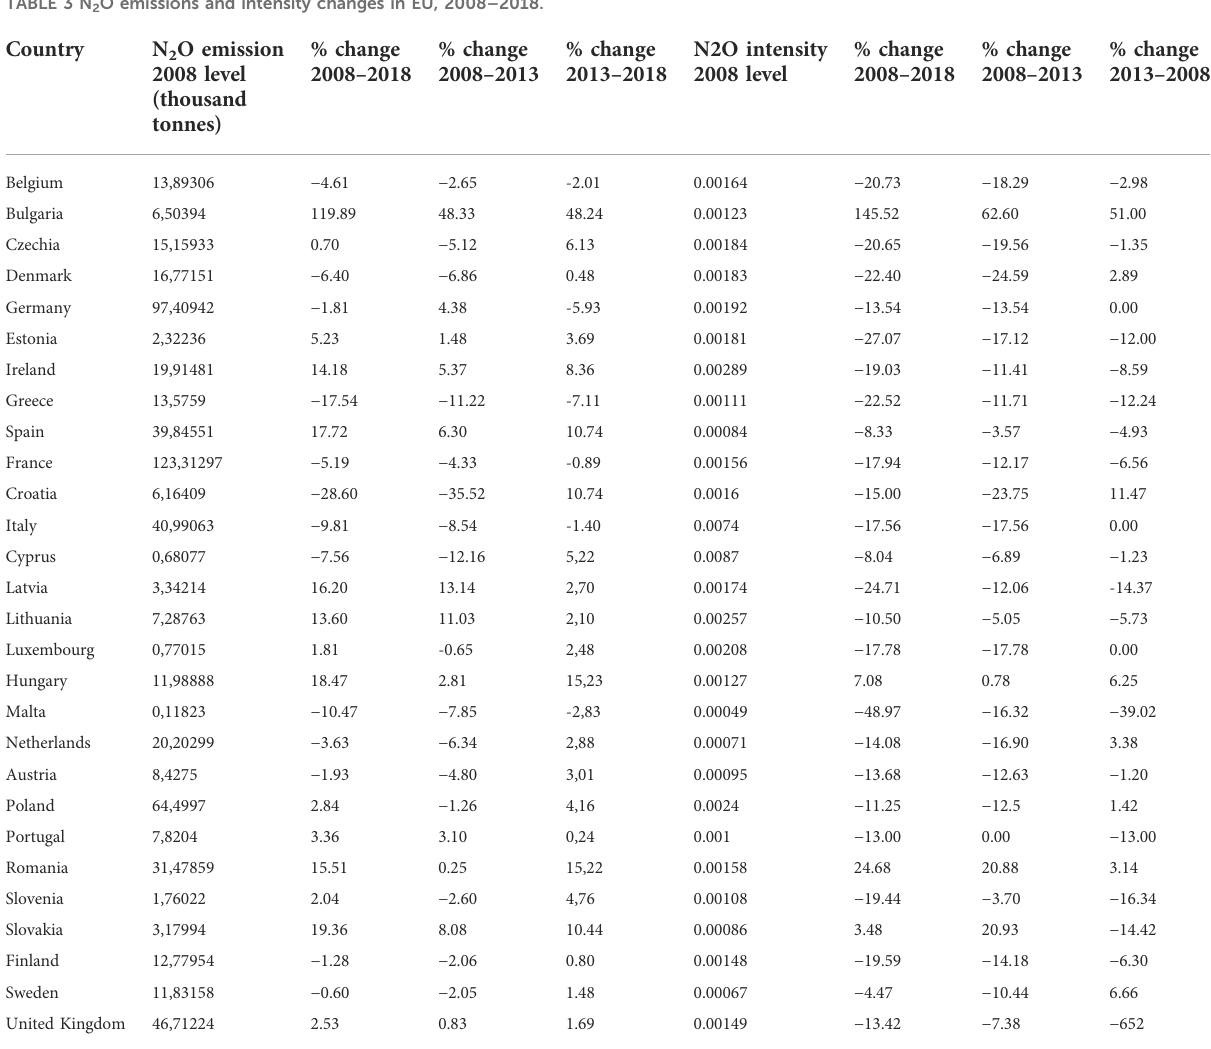
TABLE 3 N 2 O emissions and intensity changes in EU, 2008 –